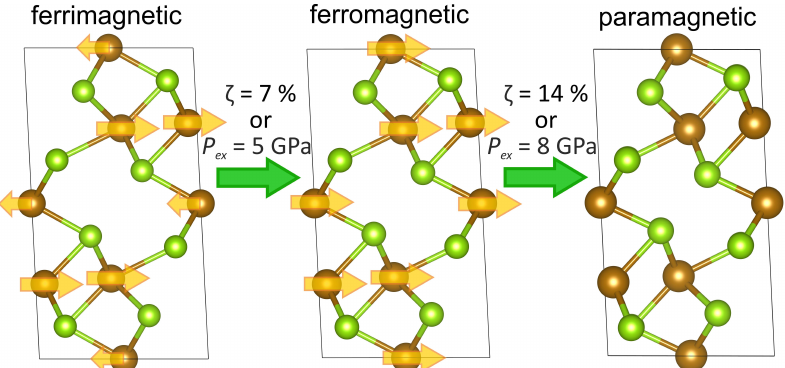
Figure 10. Illustration of the Fe 3 Se 4 transformation under the applied isotropic strain ξ or the isotropic external pressure P ex between the ferrimagnetic and the paramagnetic states through the ferromagnetic state. Brown and yellow-green colors correspond to Fe and Se atoms, respectively. The arrows indicate the direction of magnetic moments on iron